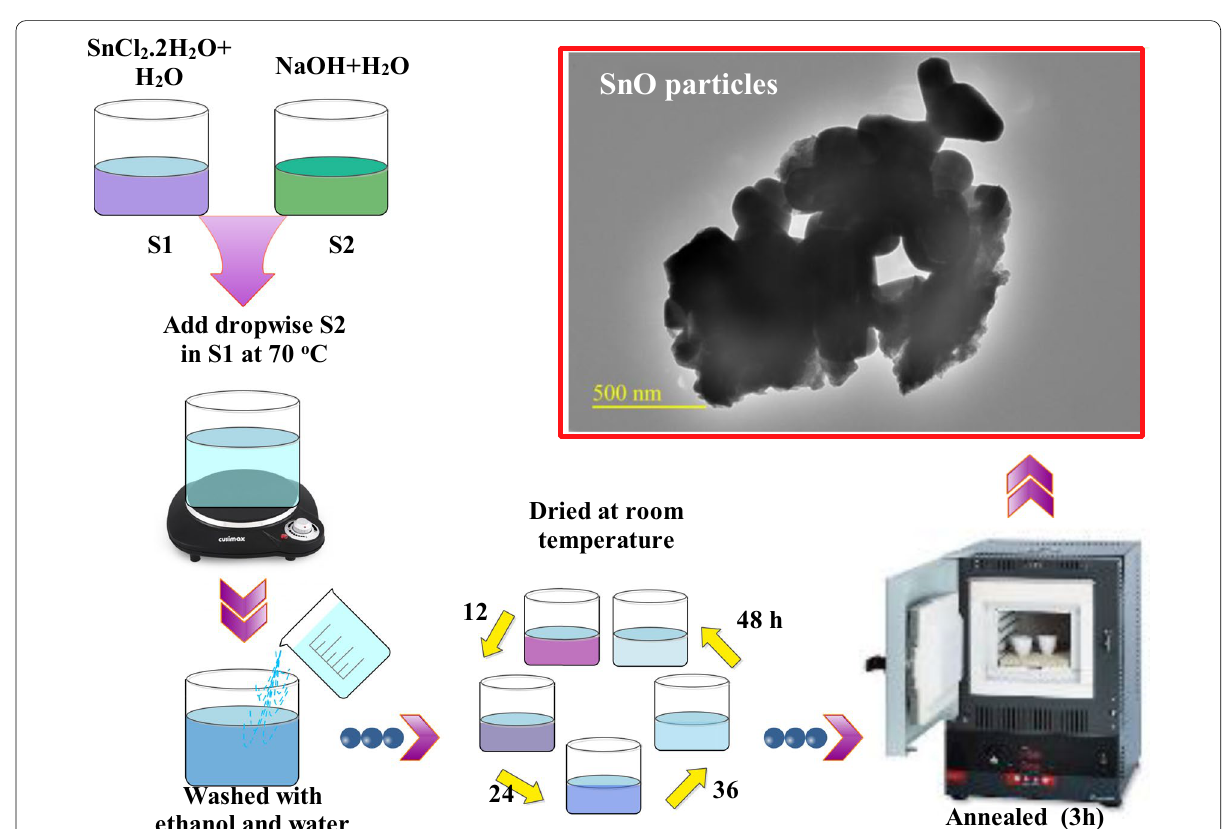
Fig. 2 Schematic representation of synthesis of tin oxide